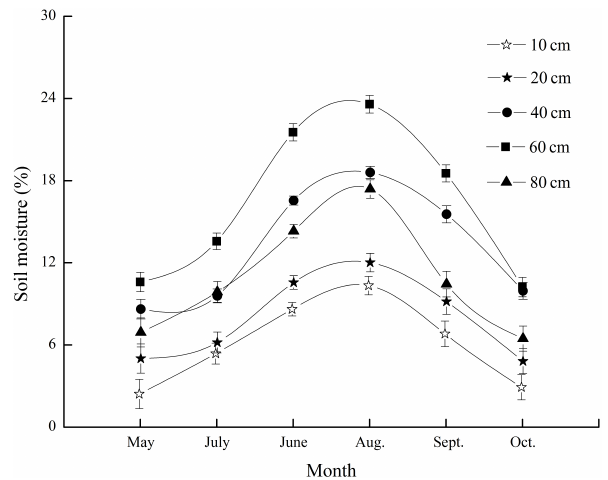
Figure 5. The variation of soil moisture content at different soil